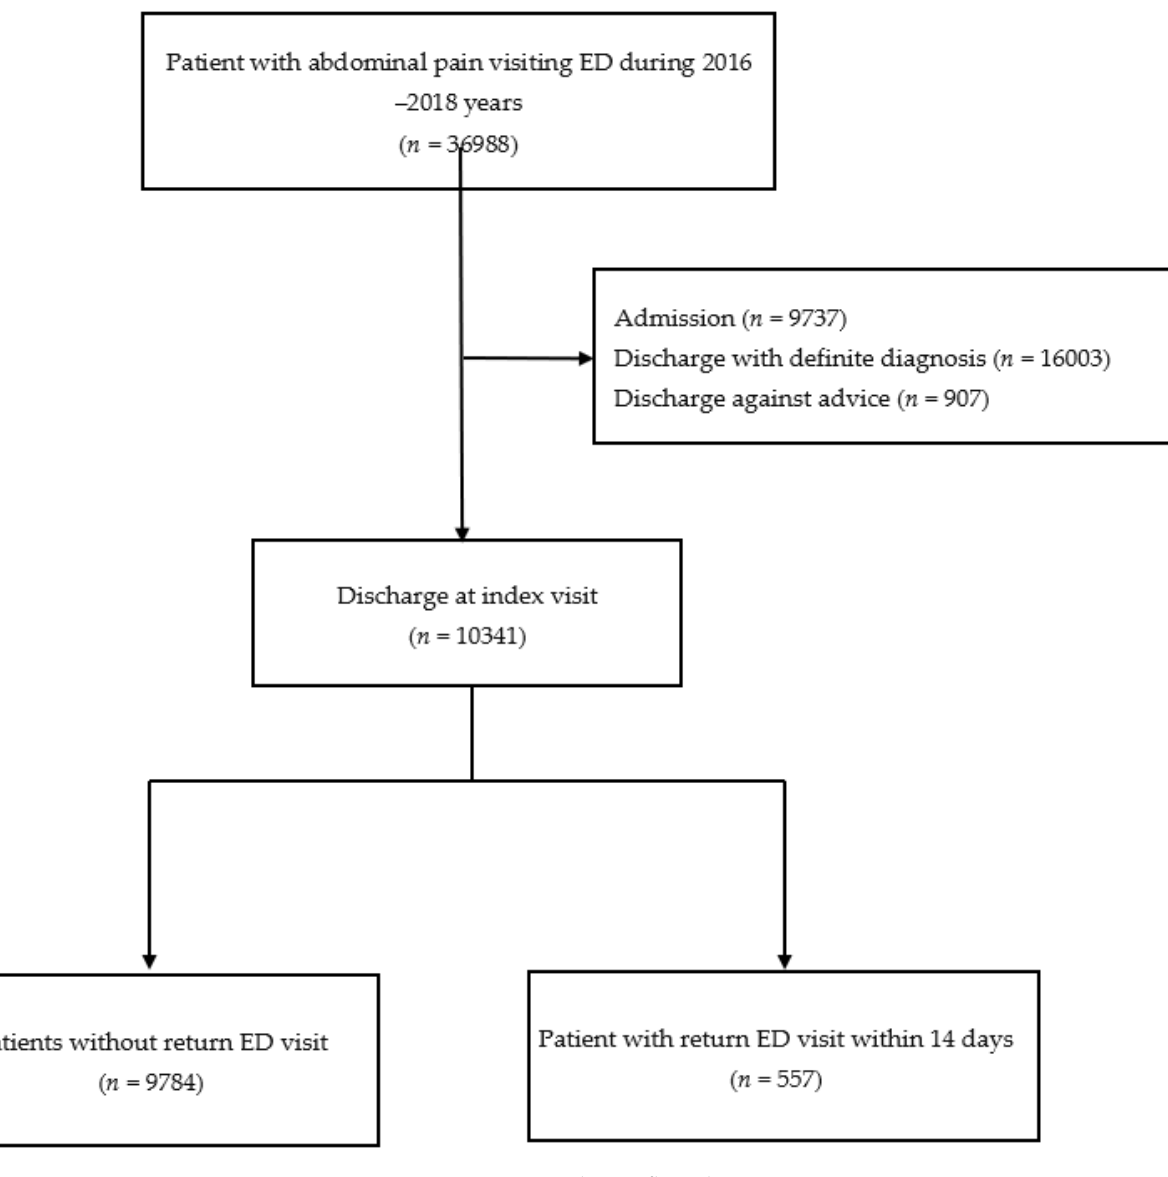
Figure 1. Patients’ inclusion flow chart.